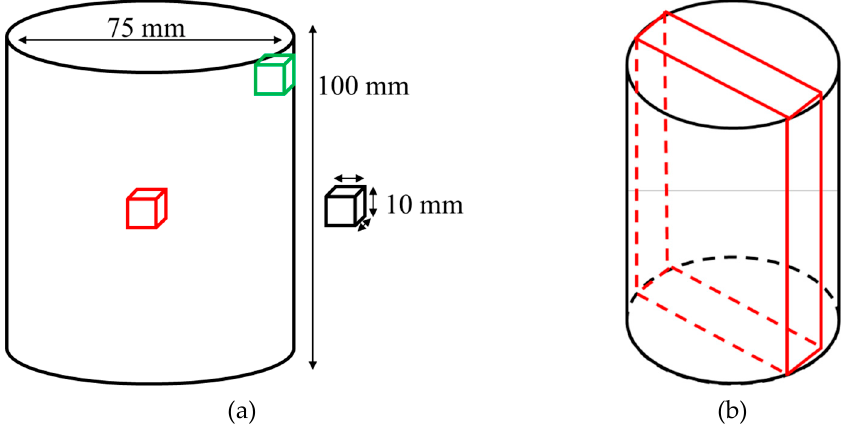
Figure 3. ( a ) Scheme of the can and cube dimensions, both after HIP, for study B. Additionally, the can microstructural analysis areas were pointed out, in red and green, for study A. ( b ) Extracted can slice for hardness mapping, study A.